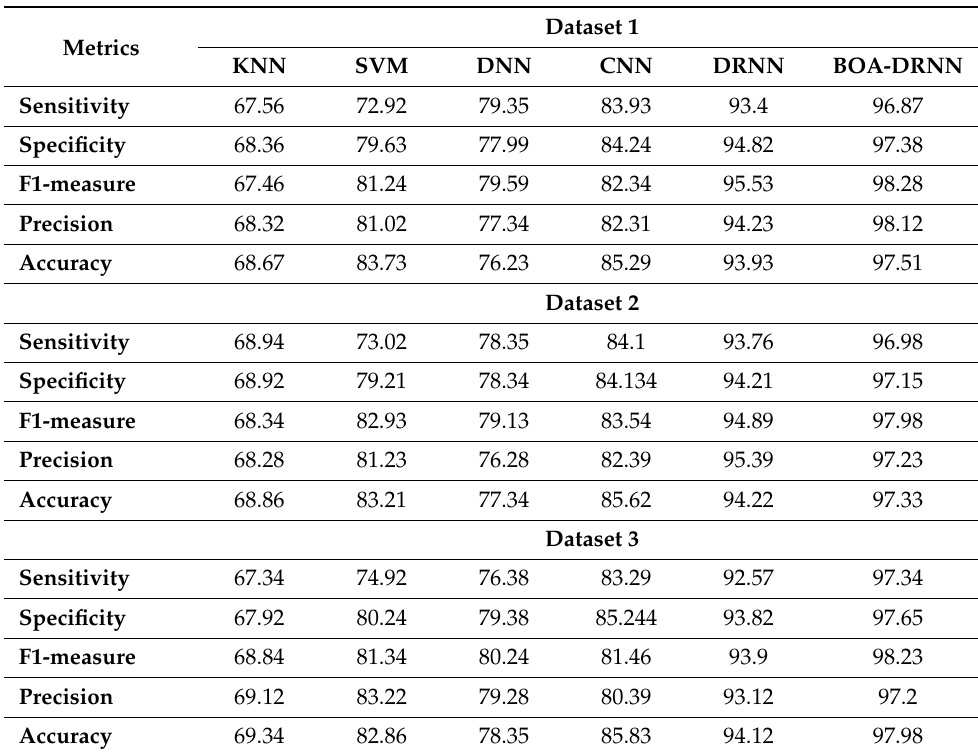
Table 3. Efficiency